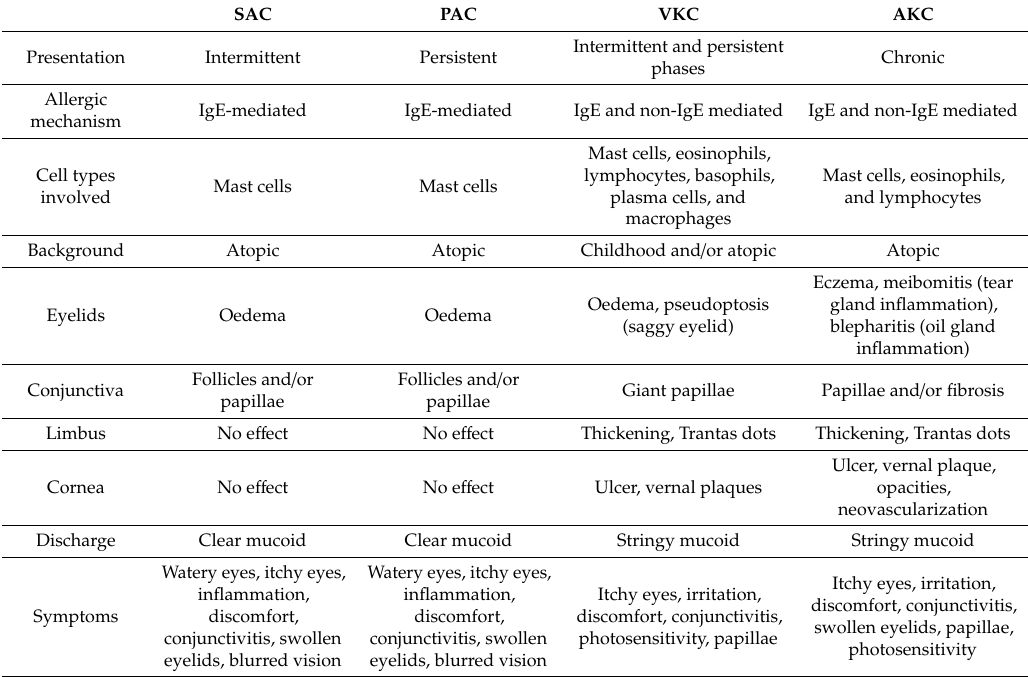
Table 1. Summary of the key similarities and di ff erences in both pathophysiology and symptomatic physiology between those su ff ering from seasonal allergic conjunctivitis (SAC), perennial